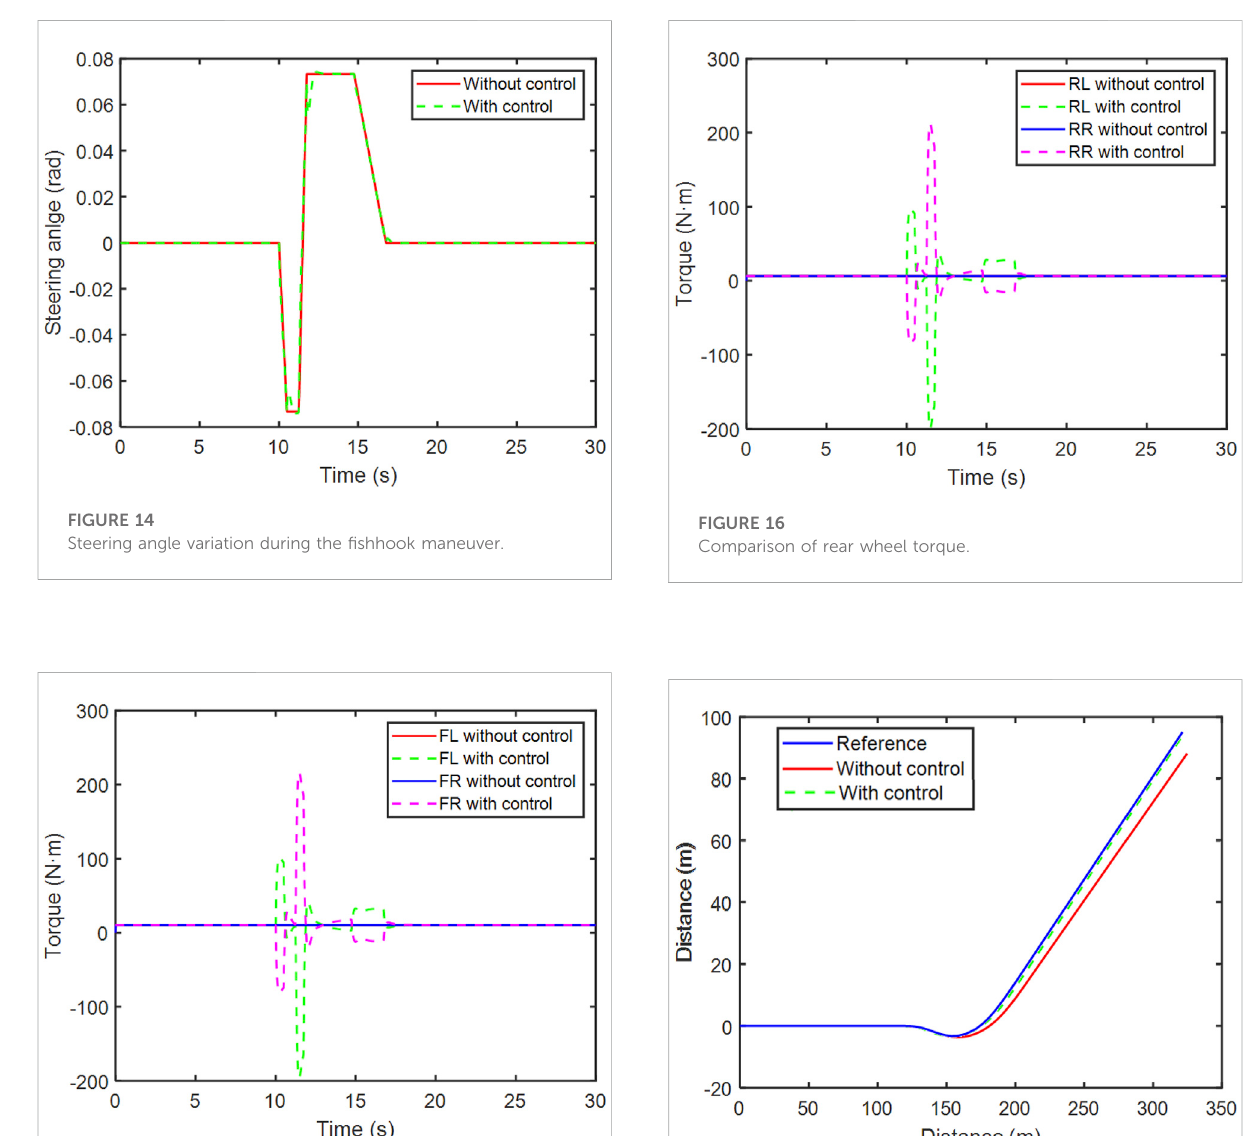
FIGURE 15 Comparison of front wheel torque.